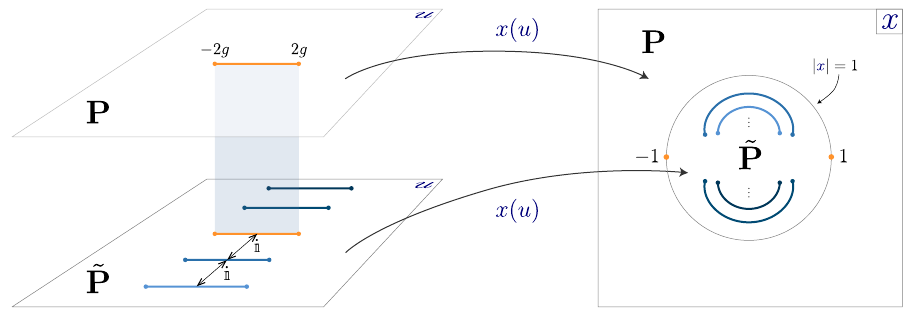
Figure 4 . Analytic structure of P and the e(cid:11)ect of the Zhukowsky map (de(cid:12)ned below in sec- tion 3.3). P has only one cut in between the branch points (cid:6) 2 g on its (cid:12)rst sheet. It connects to the second sheet where ~ P has an in(cid:12)nite number of cuts at (cid:6) 2 g + i Z . The Zhukowsky map resolves the cut at (cid:6) 2 g while mapping the (cid:12)rst sheet onto the exterior of the unit circle and the second into the interior. The plot uses the example value g = 2 and indicates the in(cid:12)nite number of cuts by ellipses in the x